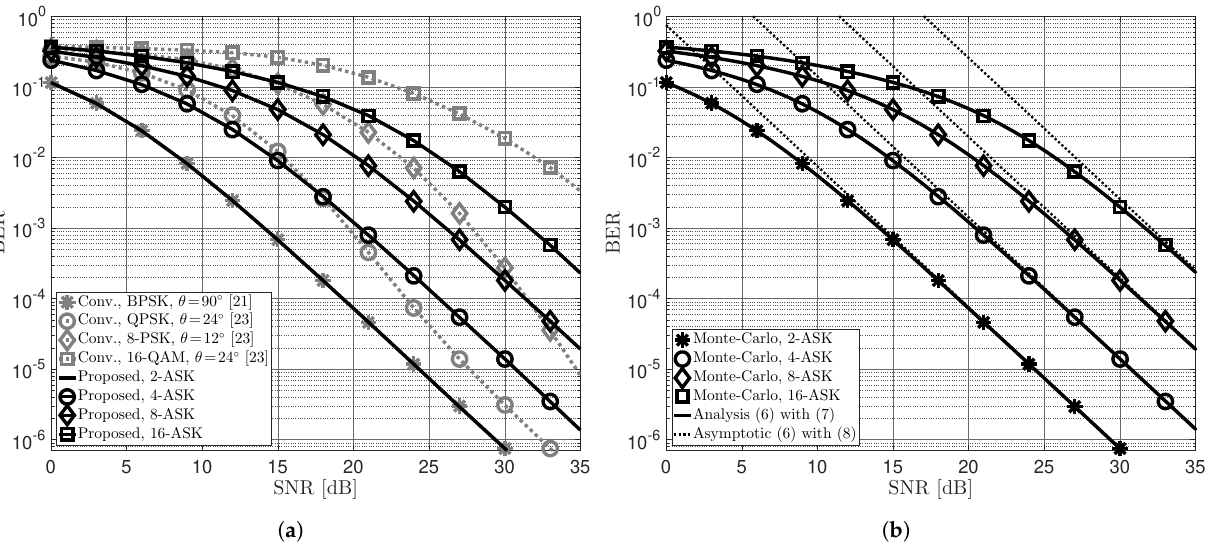
Figure 2. Average BER performance of two STAs in the proposed low-complexity uplink STLC- NOMA and conventional STLC-NOMA systems. ( a ) Numerical BER performance of the proposed STLC-NOMA (Proposed) and conventional STLC-NOMA (Conv.) [23]. ( b ) Analytic and asymptotic BER performance of the proposed